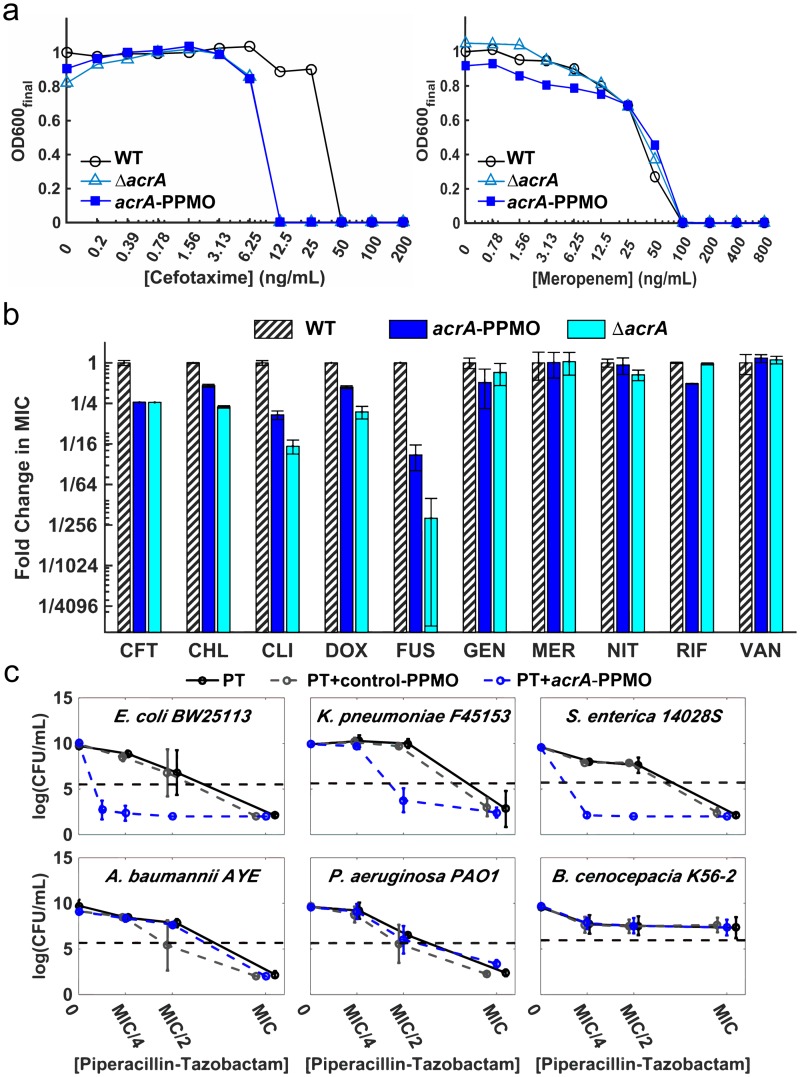
acrA-PPMO confers hypersensitivity to several antibiotics in a sequence-specific manner.(A) Sample antibiotic dose-response curves of E. coli in the absence of acrA-PPMO (black lines), in the presence of 10 μM acrA-PPMO (blue lines), and E. coli with acrA deletion (cyan lines). The MIC for each treatment is defined as the lowest concentration of antibiotic that results in a 95% reduction in the growth relative to the wild type E. coli in the presence of antibiotics (black lines). (B) Bar graphs of the measured fold changes in MIC values for wild-type E. coli in the absence of acrA-PPMO (black), 10 μM acrA-PPMO (blue), and with the acrA deletion (cyan). Abbreviations: CFT, cefotaxime; CHL, chloramphenicol; CLI, clindamycin; DOX, doxycycline; FUS, fusidic acid; GEN, gentamycin; MER, meropenem; NIT, nitrofurantoin; RIF, rifampicin; VAN, vancomycin. Every measurement was completed with four replicates, and error bars represent standard deviation. Phenotypic effects of acrA deletion and acrA silencing with acrA-PPMO are highly correlated (r = 0.94, p < 0.001, Pearson correlation test). (C) Killing of E. coli (BW25113), K. pneumoniae (F45153), S. enterica (14028S), Acinetobacter baumannii (AYE), Pseudomonas aeruginosa (PAO1), and Burkholderia cenocepacia (K56-2) by piperacillin-tazobactam alone (black line) or in combination with 10 μM control-PPMO (grey dashed line), or acrA-PPMO (blue dashed line) after 18 h incubation. The horizontal dashed line represents the inoculum (5 x 105 CFU/mL) prior to incubation. The x-axis represents the normalized MIC concentration of piperacillin-tazobactam, corresponding to different MIC values for each pathogen. Error bars represent the standard deviations of the colony forming unit (CFU) counts obtained from at least four replicate measurements.